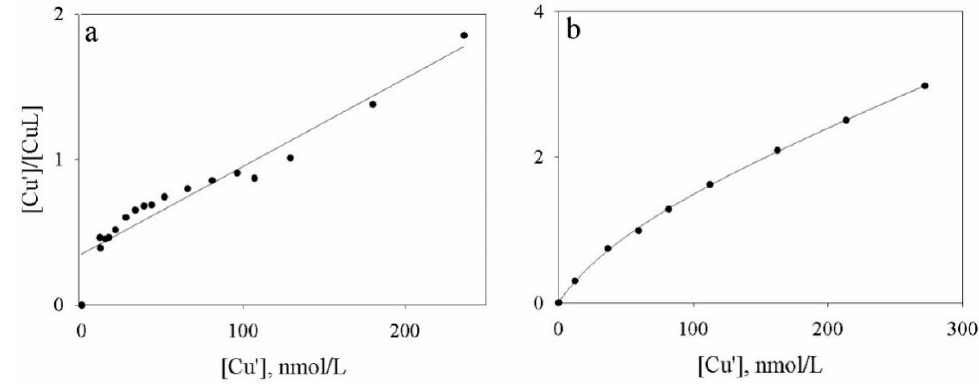
Figure 5. Plot of the elaborated data obtained from the ASV titration ( a ) and obtained from HPSEC-ICP-MS titration ( b ) for Cu.